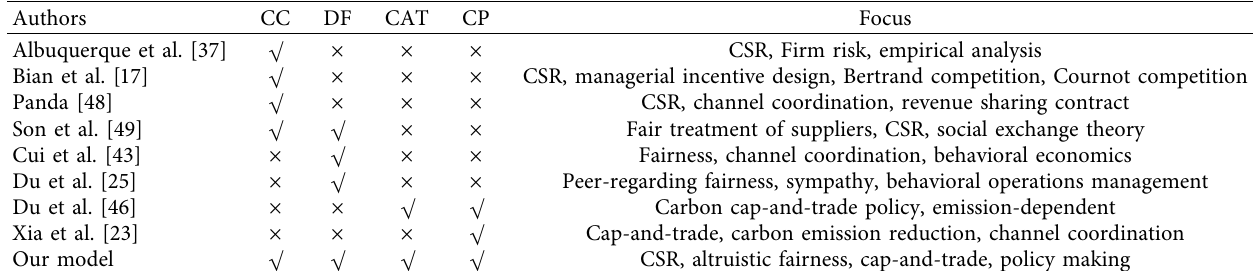
Table 1: Our paper vs. the other key literature.